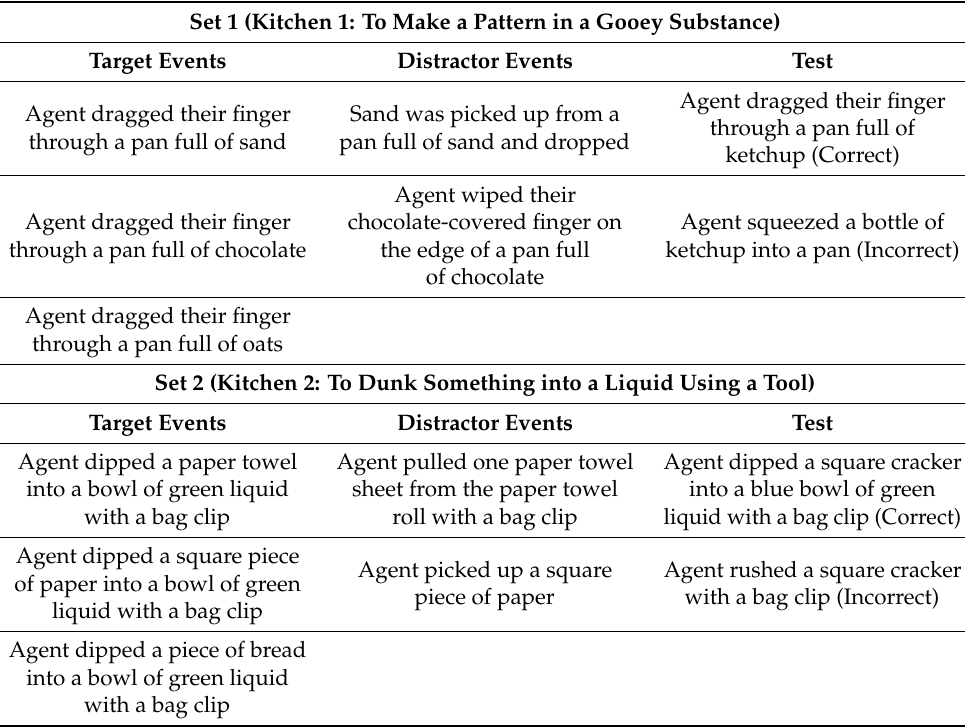
Table A1. Target Event: